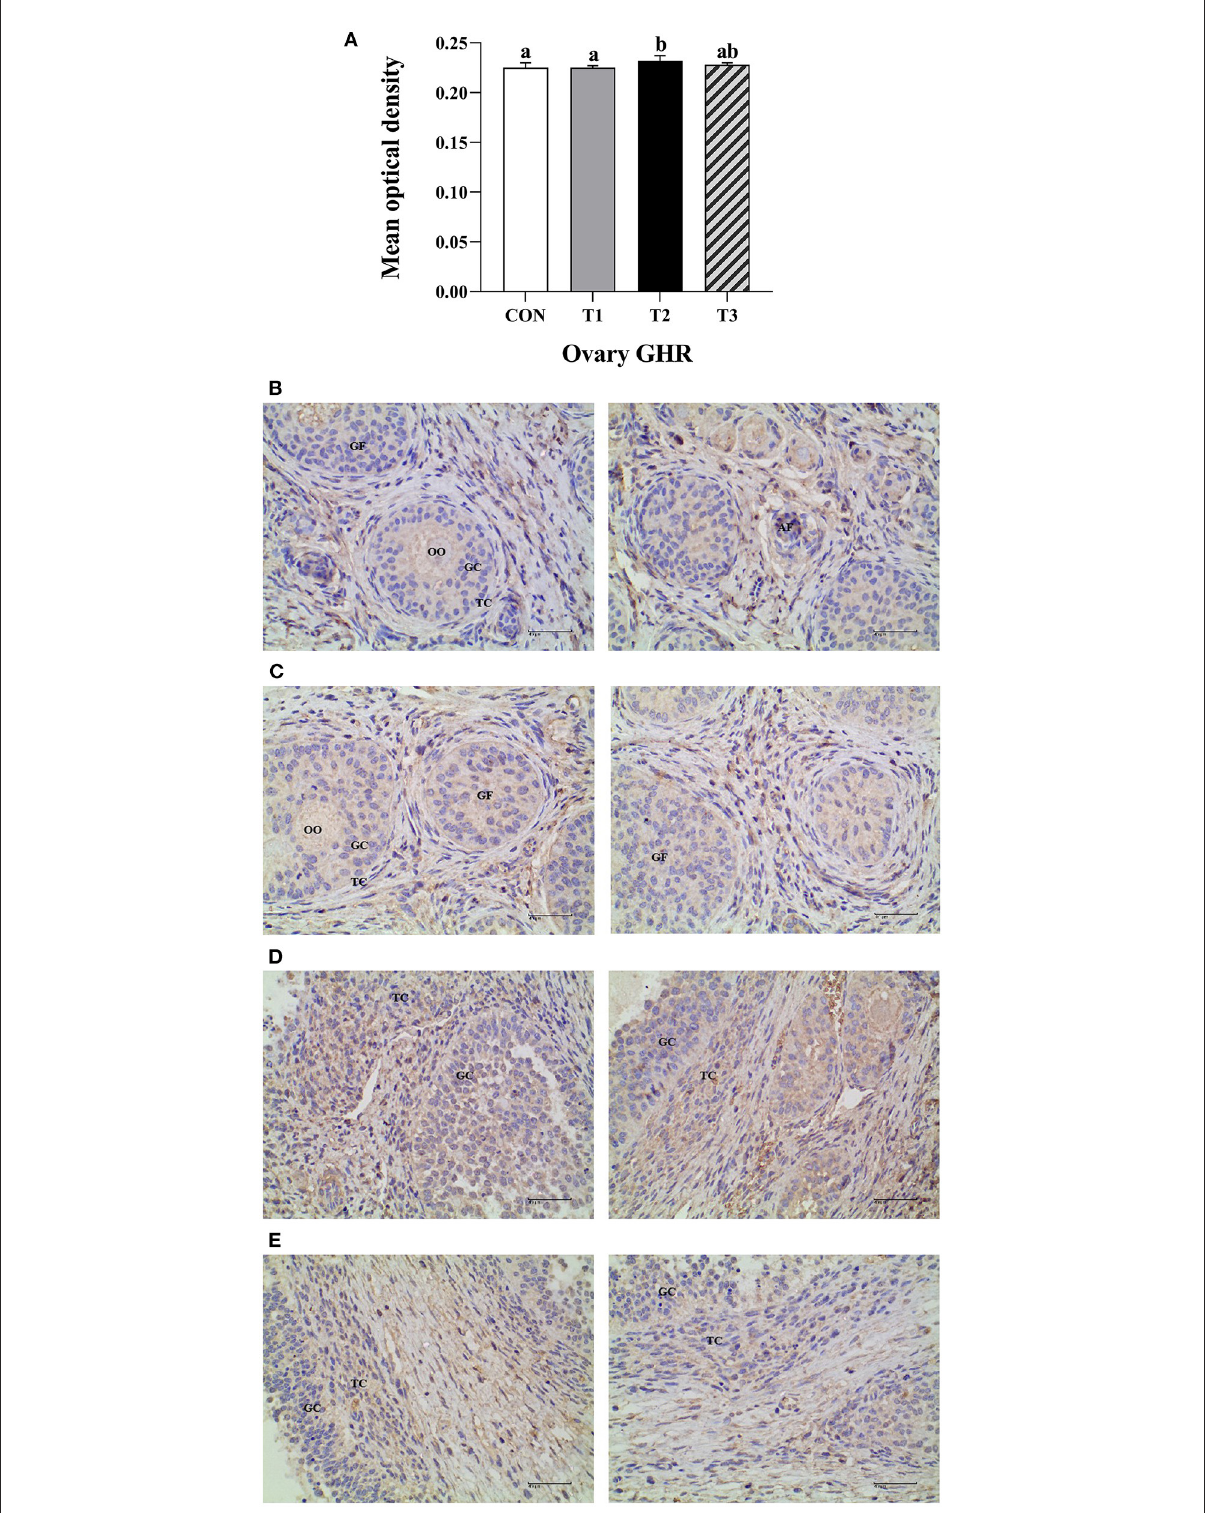
FIGURE4 Effects of ZEN on the GHR immunoreactive distribution in the prepubertal gilts ovary. Above the bar no letter or the same letter mean no significant ( P > 0.05), while with different letter mean significant difference ( P < 0.05) ( n = 12) (A) . Visual fields of ovarian tissues obtained from the CON (B) , T1 (C) , T2 (D) , and T3 (E) experimental groups. All the images were taken at X400 magnification. Key: Primordial follicle (PF), Growing follicle (GF), Atresia follicle (AF), Oocyte (OO), Granulosa cell (GC), Theca cell (TC). The scale bar represents 40 µ